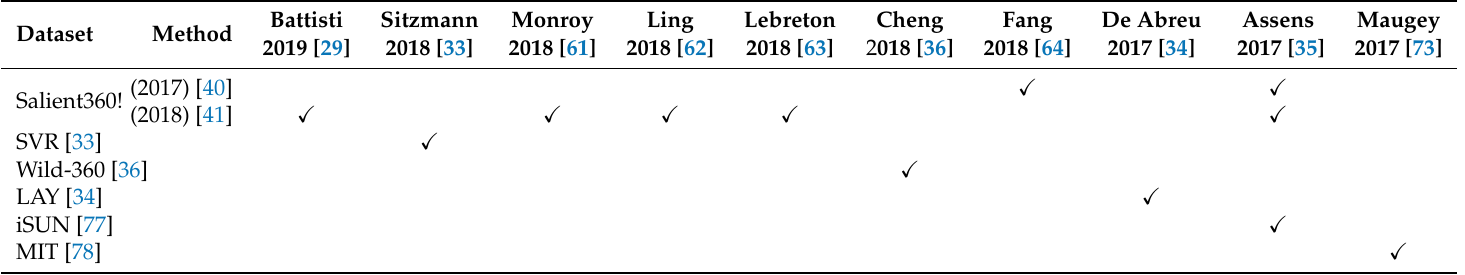
Table 2. Dataset/method matrix for visual saliency estimation in omnidirectional images.